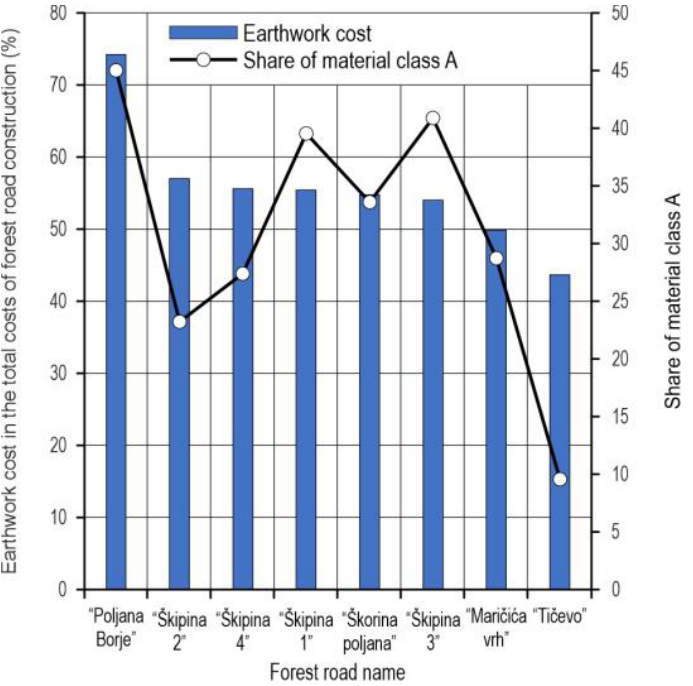
Figure 10. Influence of the share of material of category A on the share of earthwork cost in total cost of forest road construction. Table 6. Number of cross section profiles per material